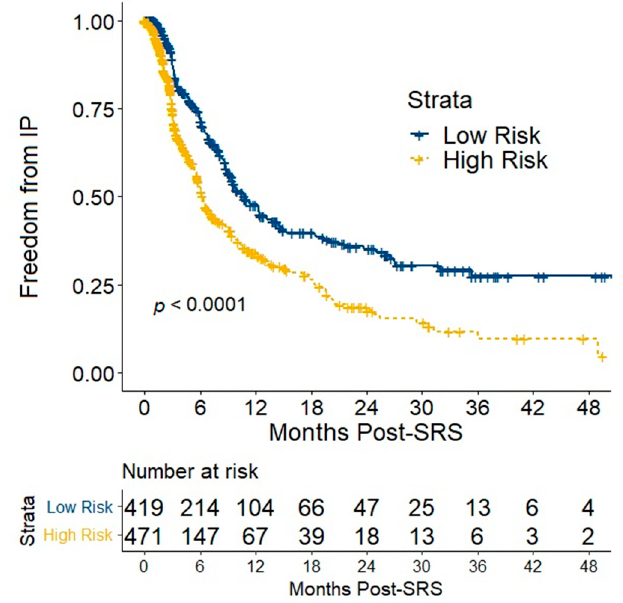
Figure 2. Freedom from intracranial progression (IP) is shown for all patients per IP nomogram risk stratification. Abbreviation: SRS, stereotactic radiosurgery. stratification. Abbreviation: SRS, stereotactic